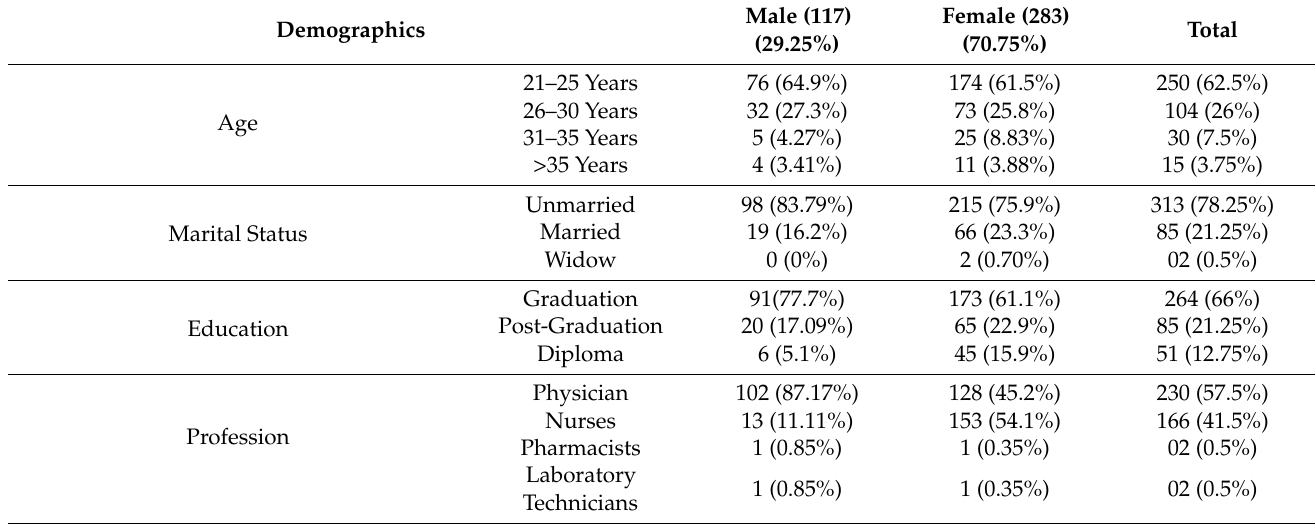
Table 1. Socio-demographic characteristics of respondents according to gender (N =